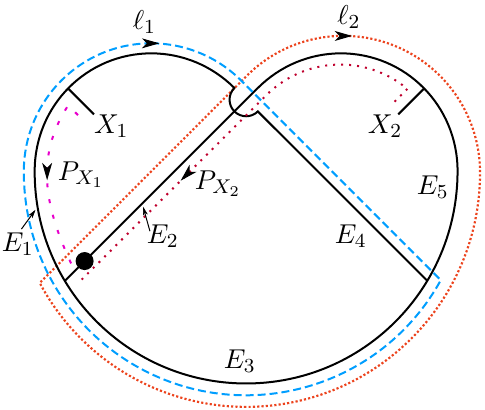
Figure 11. A non-planar graph (cid:0) with g = 2 loops and n = 2 external edges (labelled X 1 and X 2 ). The internal edges are labelled E i , i = 1 ; : : : ; 5. A loop basis f ‘ 1 ; ‘ 2 g is indicated. The base point is marked as a black dot; the chosen paths from the external edges to the base point are marked as P X and P X 1 1